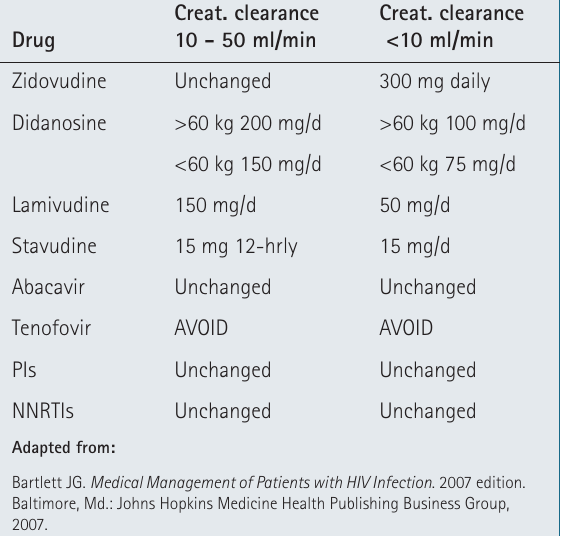
tAble X. ARV dosAGes iN ReNAl